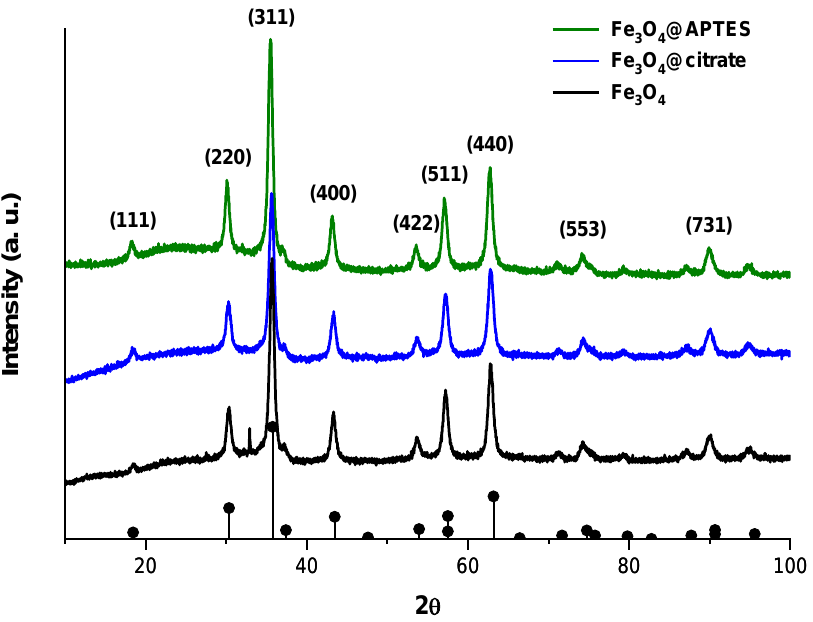
Figure 1. XRD patterns of the uncoated magnetite (Fe 3 O 4 ) and magnetite samples coated with so- dium citrate (Fe 3 O 4 @citrate) and APTES (Fe 3 O 4 @APTES).